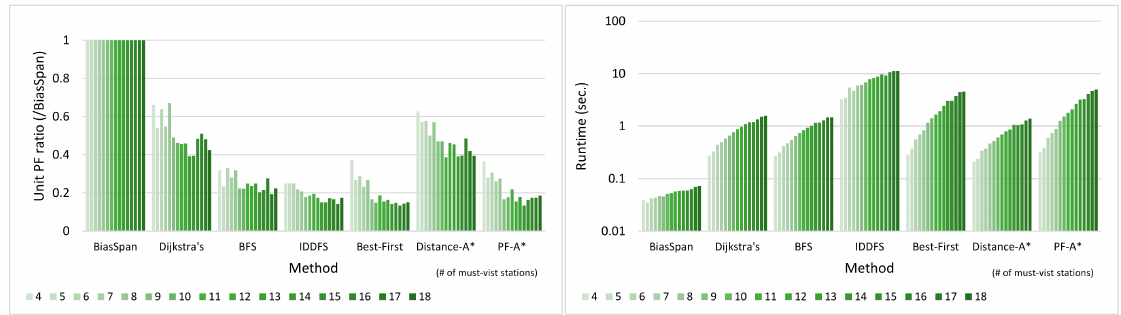
Figure 11. Unit PF ratio ( left ) and runtime ( right ) for different methods under number of must-visit stations in Chicago dataset.